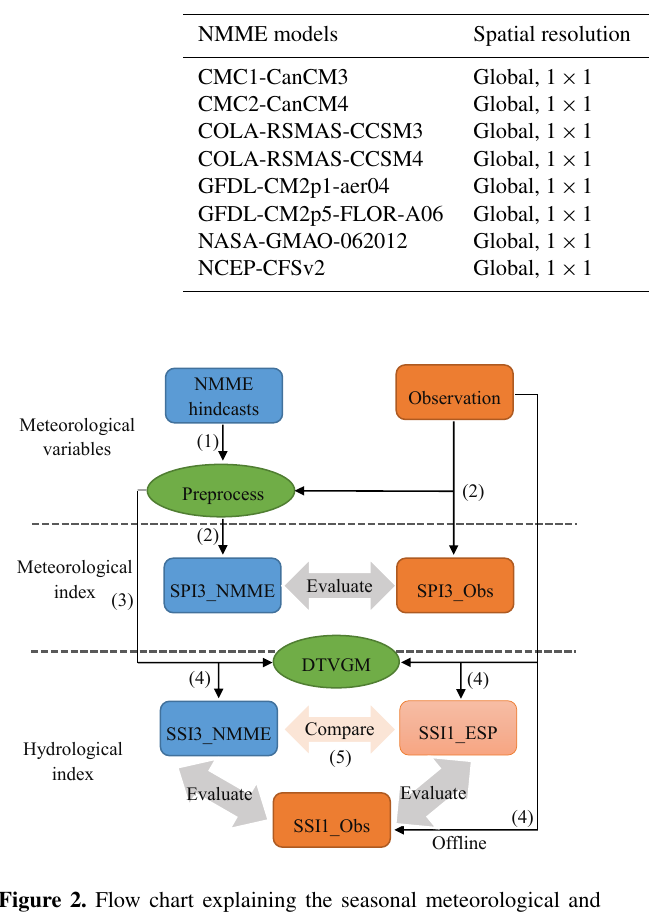
Table 1. Information of NMME models.